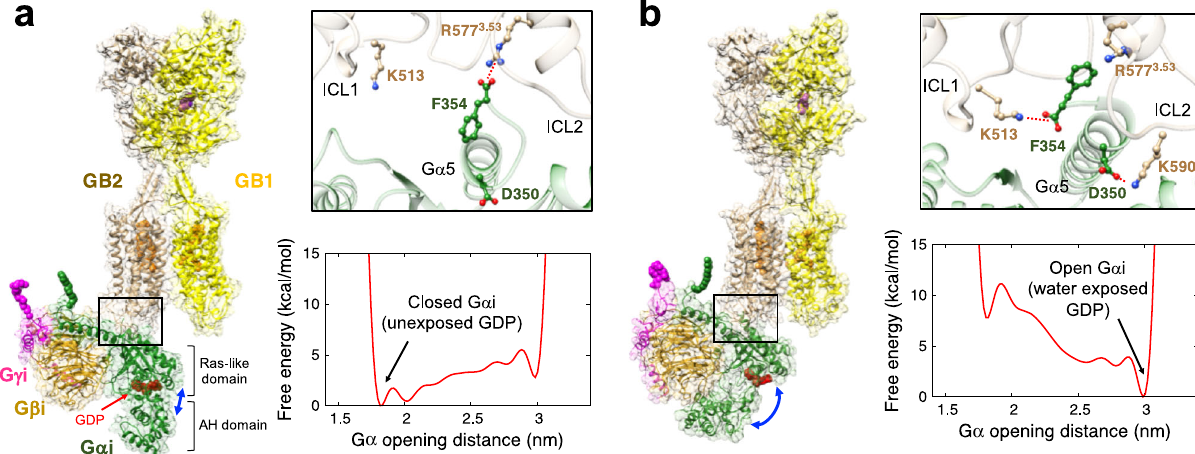
Fig. 4 | The opening of the G α subunit from the pre-activated agonist- GABA B R-G i P structure. The structures and energy pro fi les starting with the pre- activated agonist-GABA B R-G i P structure by metaD simulations show that a the opening of the G α subunit is energetically unfavourable while the G α 5 helix is in